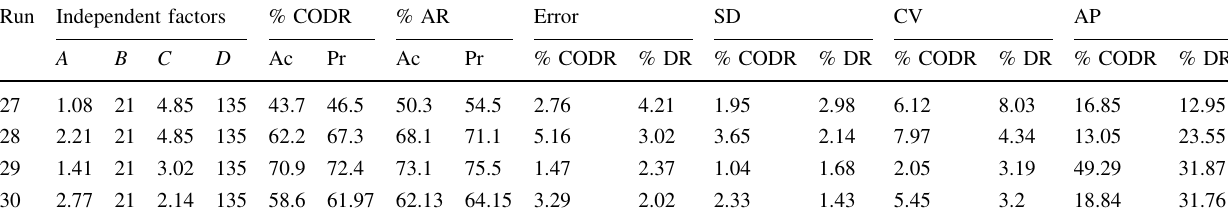
Table 6 Optimization of additional experiments Run Independent factors